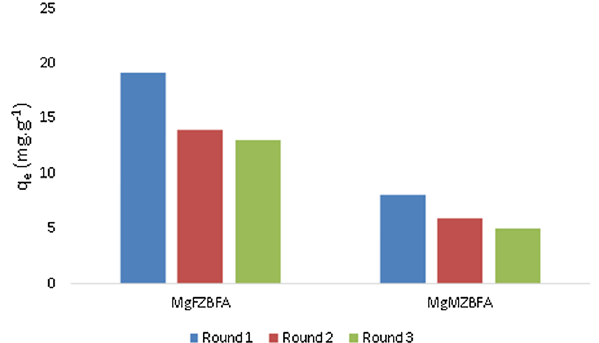
Fig. 20 Regeneration (from NB sorption) and reuse of MgFZBFA and